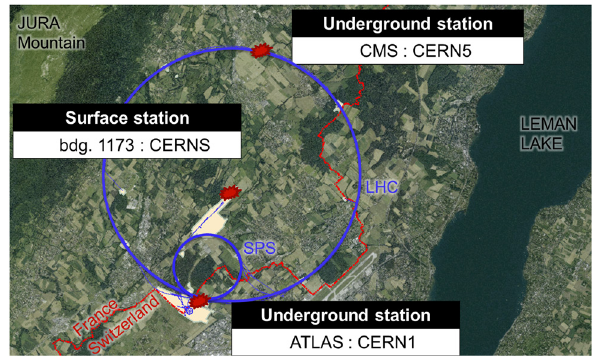
Figure 1: Map of CERN Seismic Network with speci fi ed locations of separate seismic stations [ 11 ] .